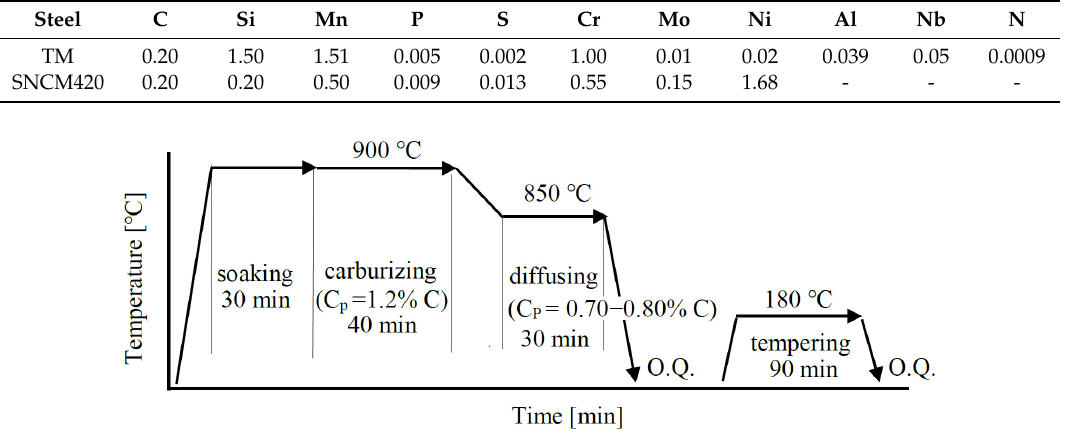
Figure 1. Vacuum-carburization and tempering diagram, in which “O.Q.” represents quenching in oil Figure 1. Vacuum ‐ carburization and tempering diagram, in which “O.Q.” represents quenching in at 80 ◦ C, C P is carbon oil at 80 °C, C P is carbon potential.